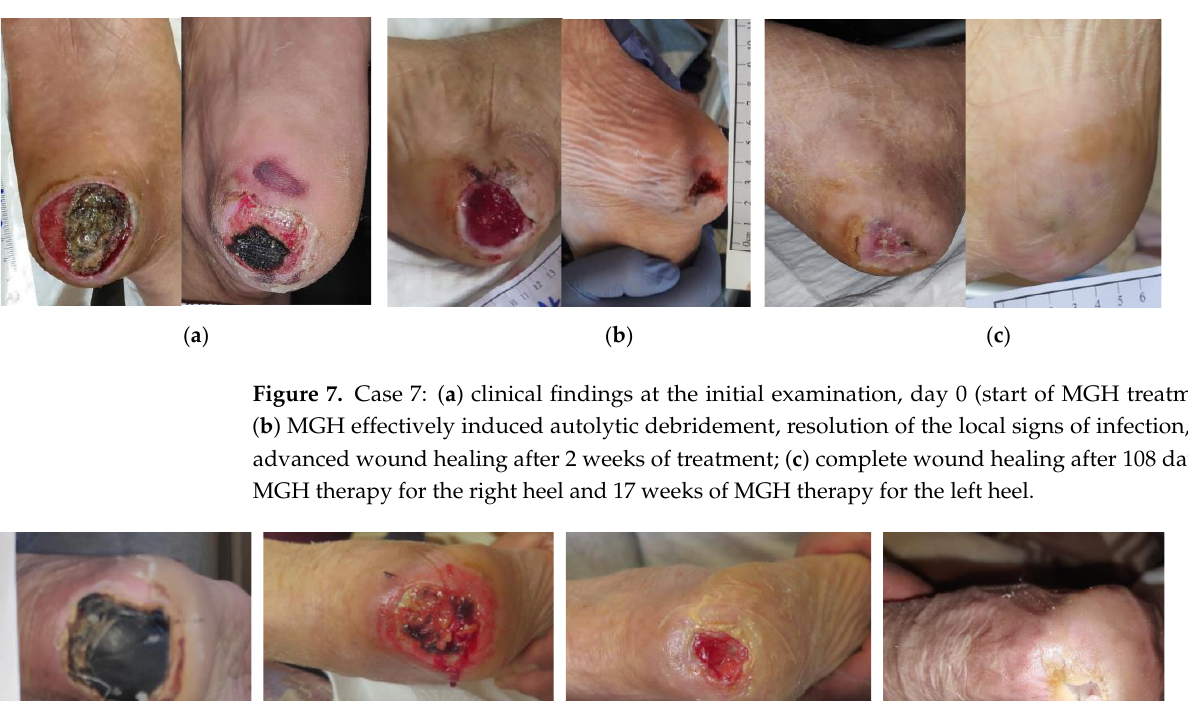
Figure 7. Case 7: ( a ) clinical findings at the initial examination, day 0 (start of MGH treatment); ( b ) MGH effectively induced autolytic debridement, resolution of the local signs of infection, and advanced wound healing after 2 weeks of treatment; ( c ) complete wound healing after 108 days of MGH therapy for the right heel and 17 weeks of MGH therapy for the left heel.